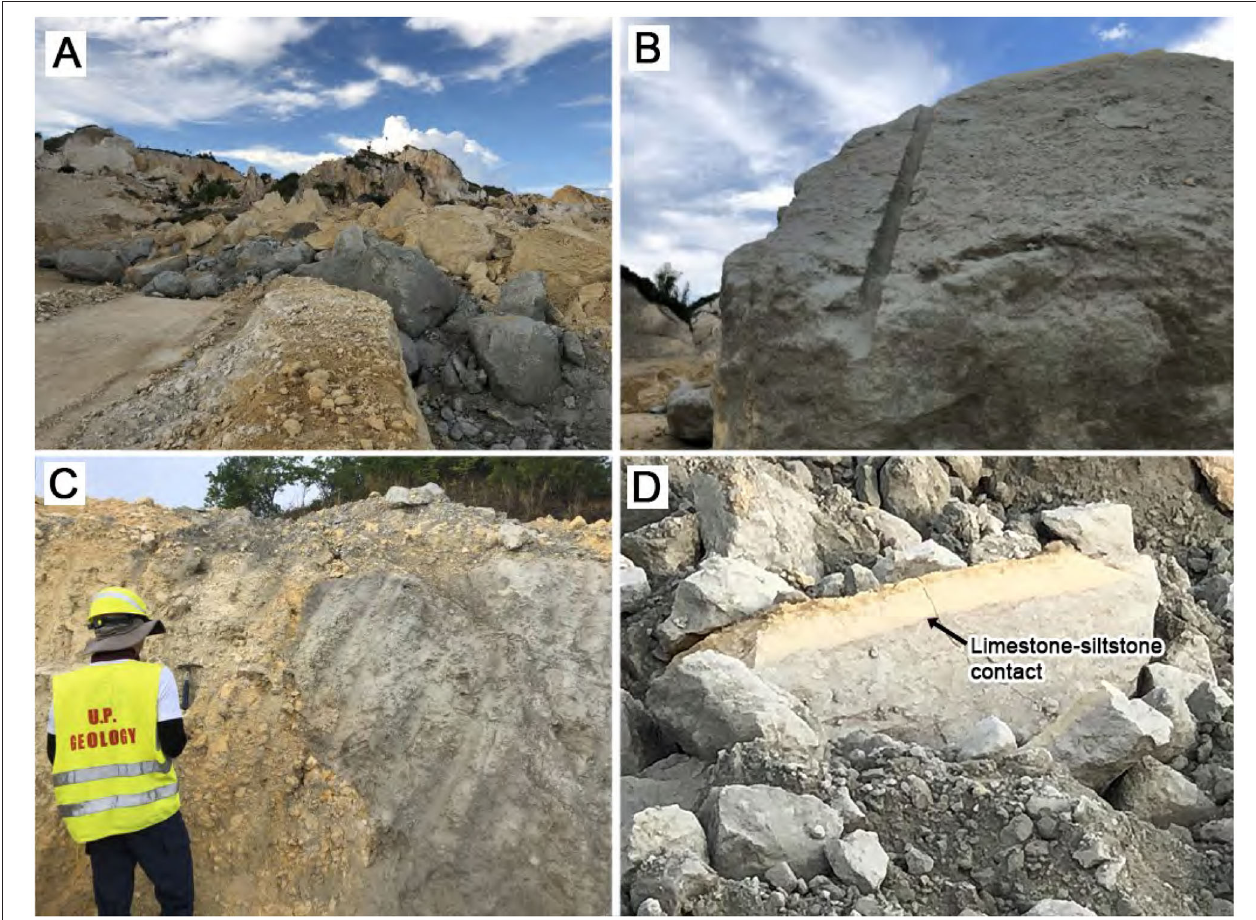
FIGURE 6 | (A) Sandstone/siltstone in the debris field of the landslide. (B) A drill hole mark is evident in a boulder. (C) Sandstone and limestone deposit. (D) The contact between the limestone and the siltsone is clearly seen in a boulder in the debris